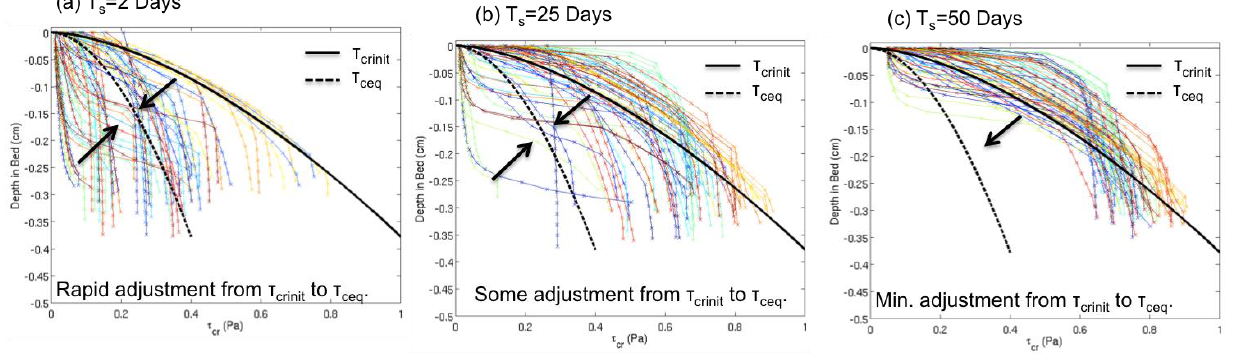
profiles (colored lines) shown with user c ) for model runs with swelling times crinit ≠ τ . Black arrows show ceq crinit profiles toward τ c ceq